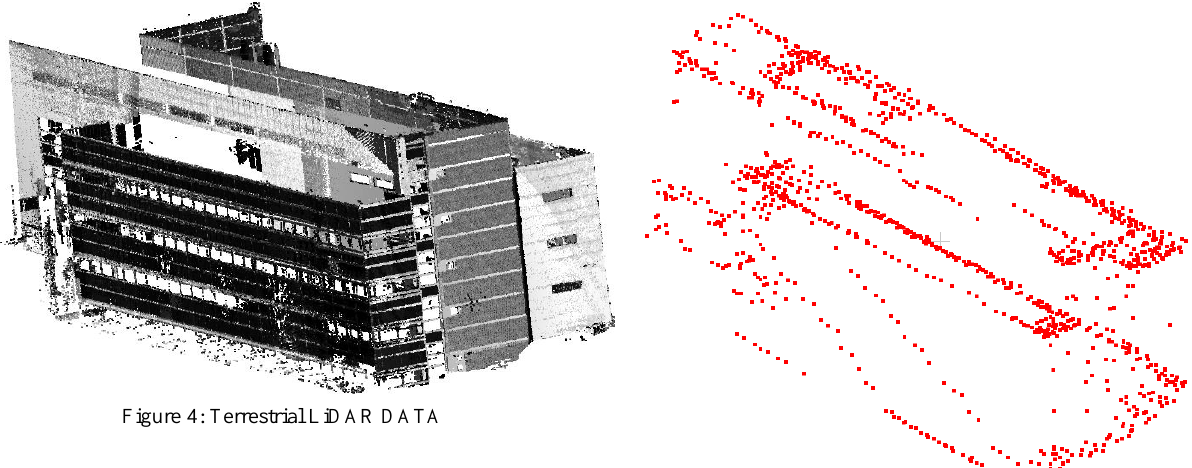
Figure 4: Terrestrial LiDAR DATA